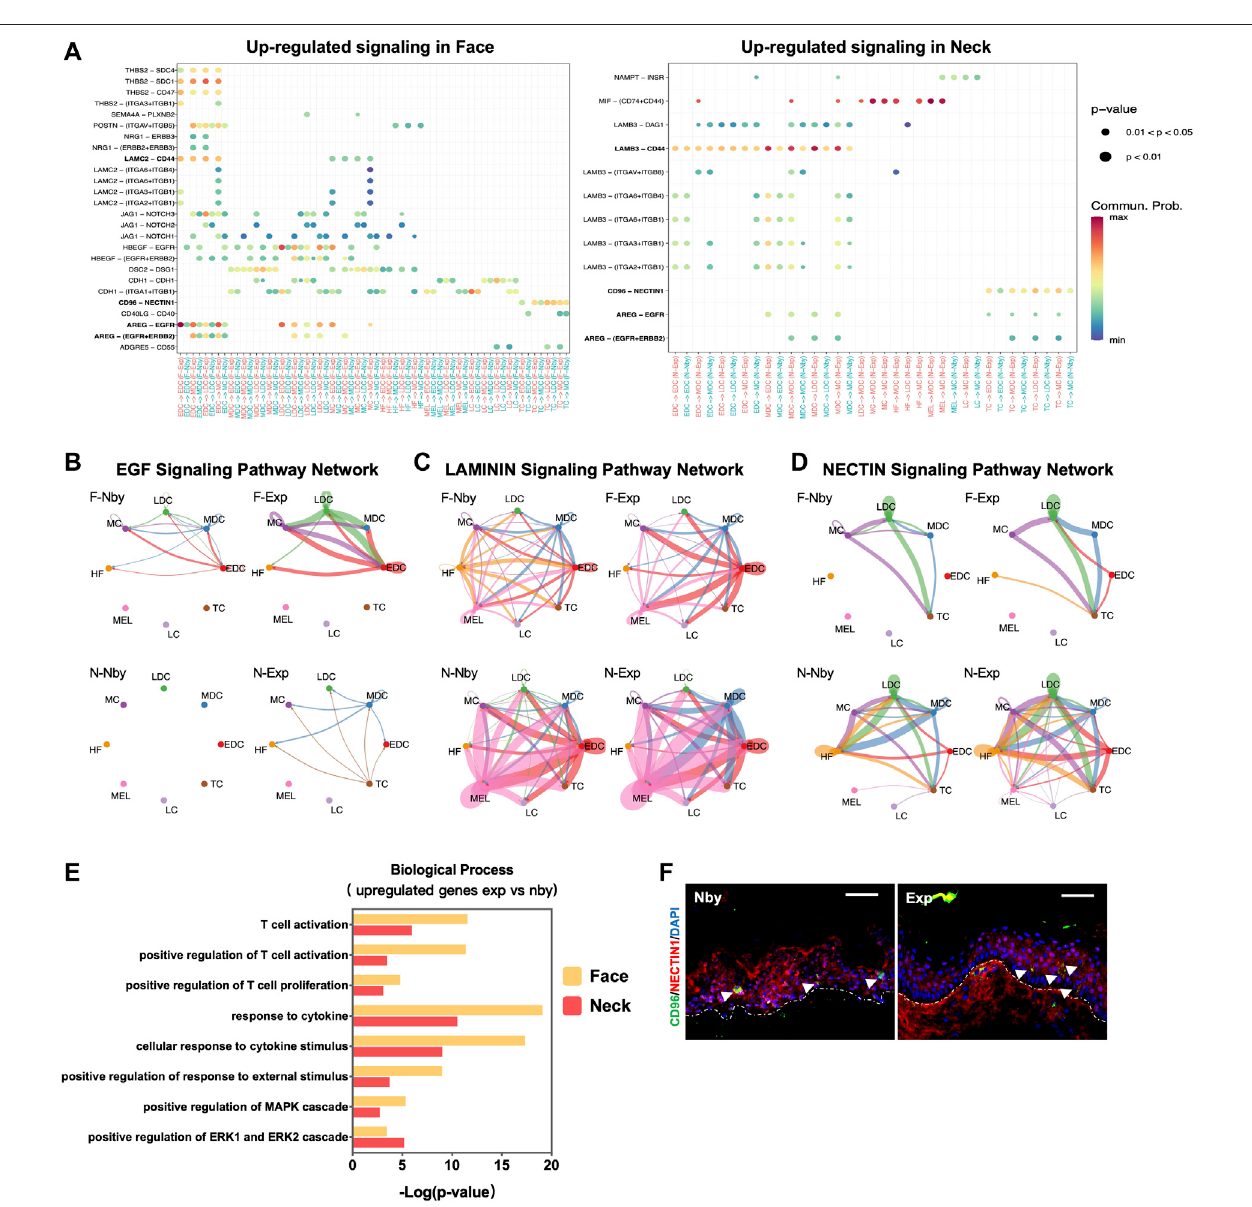
FIGURE6| Intercellular ligand – receptor prediction. (A) Visualizationand comparison ofthesigni fi cantupregulatedligand-receptor pairs intheexp vs. nbygroups. Dot color re fl ects communication probabilities, and dot size represents computed p -values. Empty space means the communication probability is zero. p -values are computed from a one-sided permutation test. (B – D) The inferred EGF, LAMIN, and NECTIN signaling networks. Different cell populations are color-coded. Circle size is proportional to the number of cells in each cell group, and edge width represents the communication probability. (E) GO biological process analysis of T cells. (F) Representative IF images of the NECTIN1 and CD96 staining in nby and exp skin. Arrows denote CD96 positive cells, and the dotted lines denote the basement membrane between the epidermis and dermis.